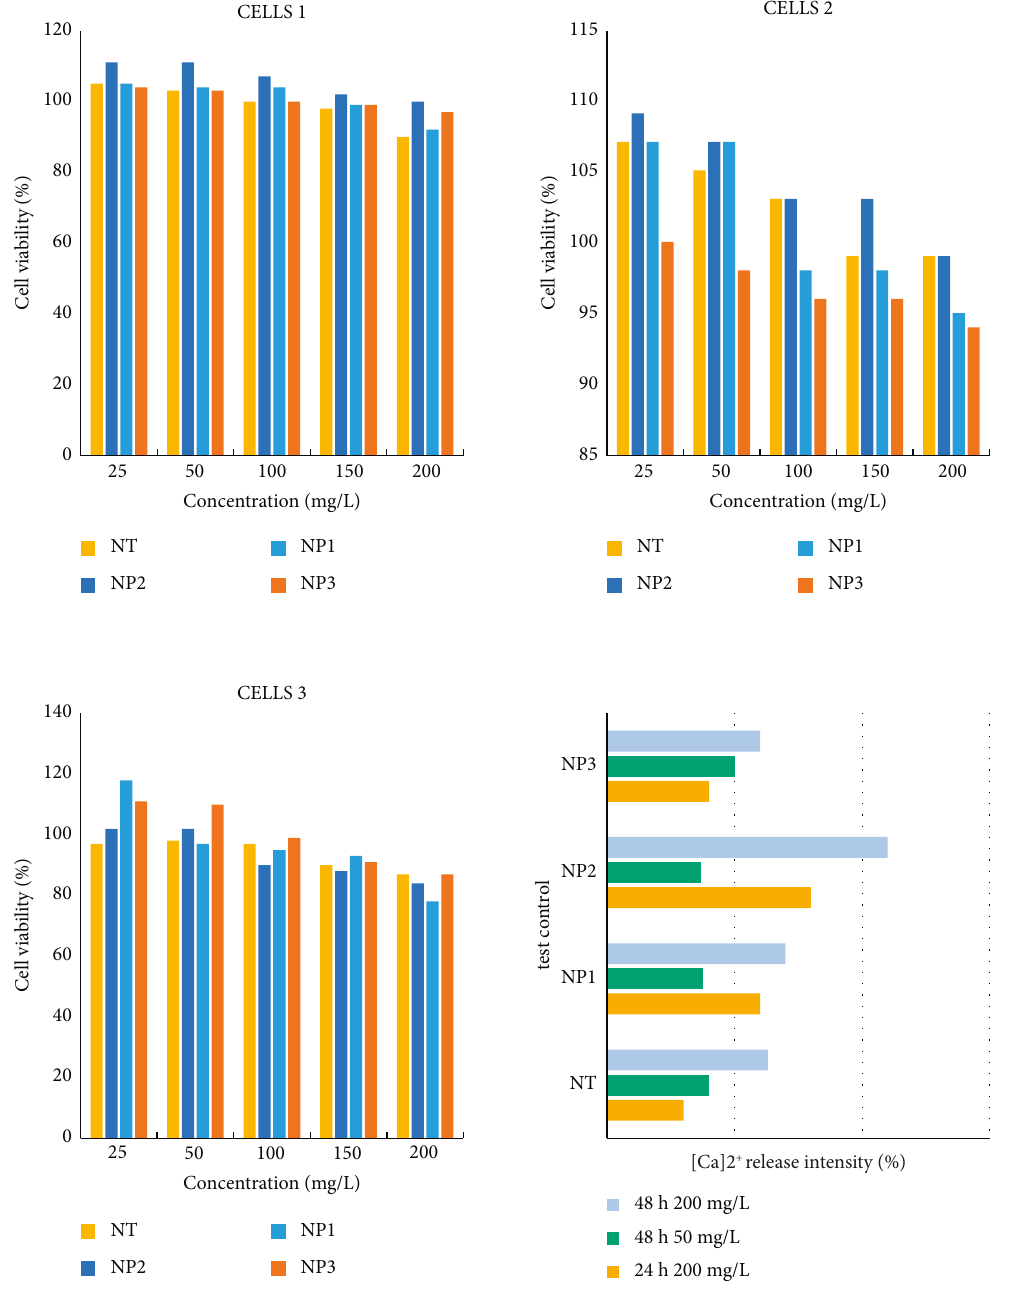
Figure 7: Cell viability after coincubation of four kinds of nano-TiO different concentrations at different